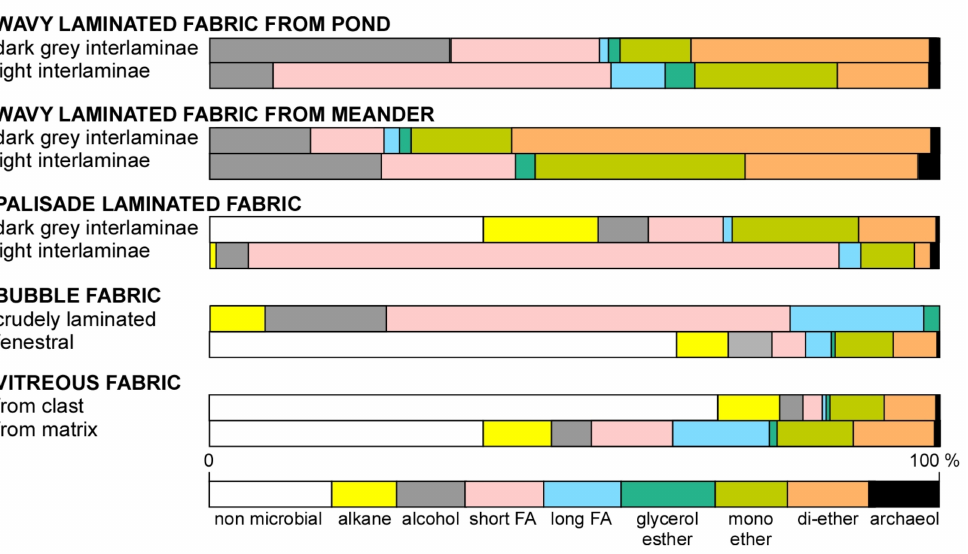
Figure 10. Relative abundance of main biomarkers from different fabrics and